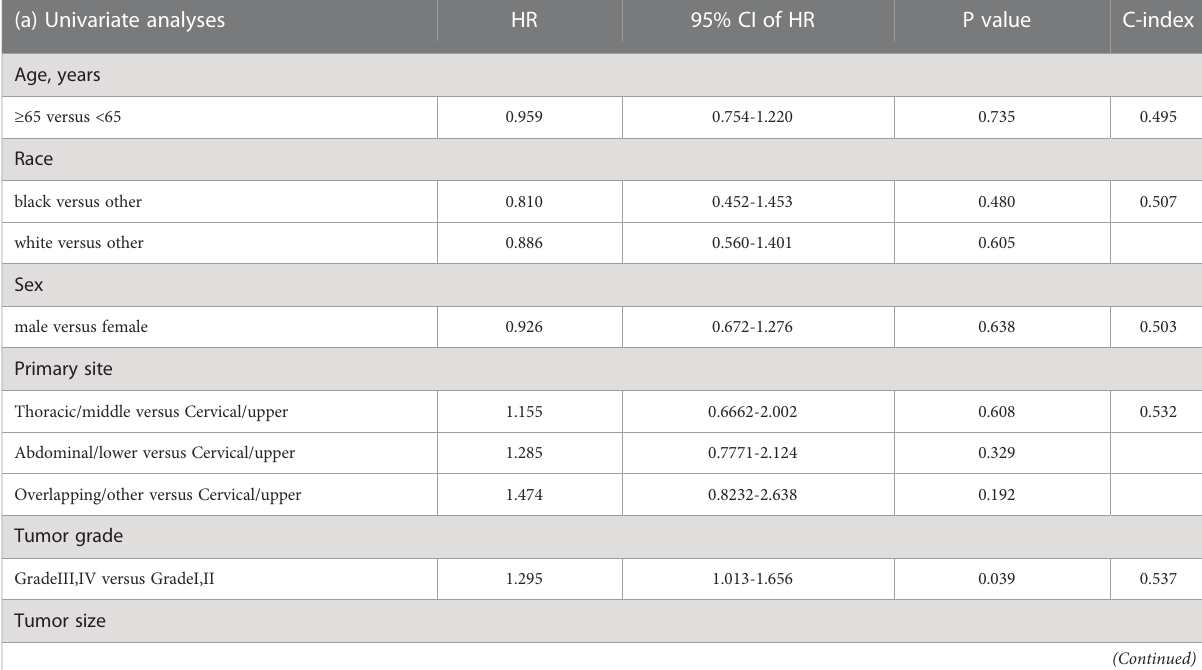
TABLE 2 Univariate and multivariate analyses were performed to investigate each factor ’ s association with